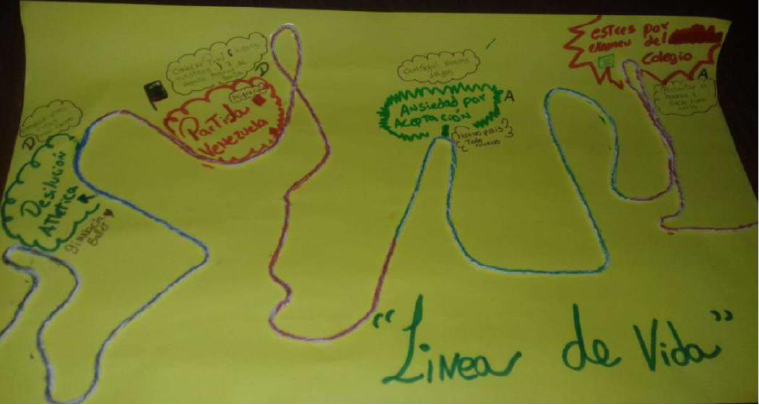
Figure 3. Lifeline drawn by a male adolescent.